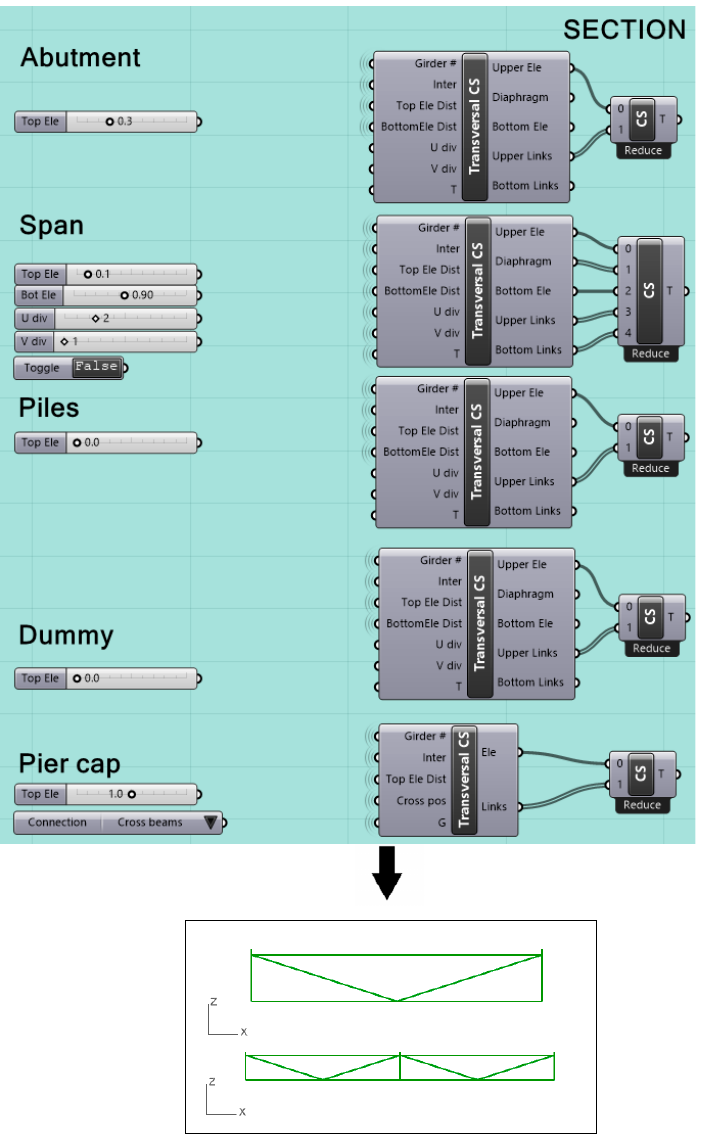
Figure 2. Cluster of Grasshopper tools to create variable transversal elements.